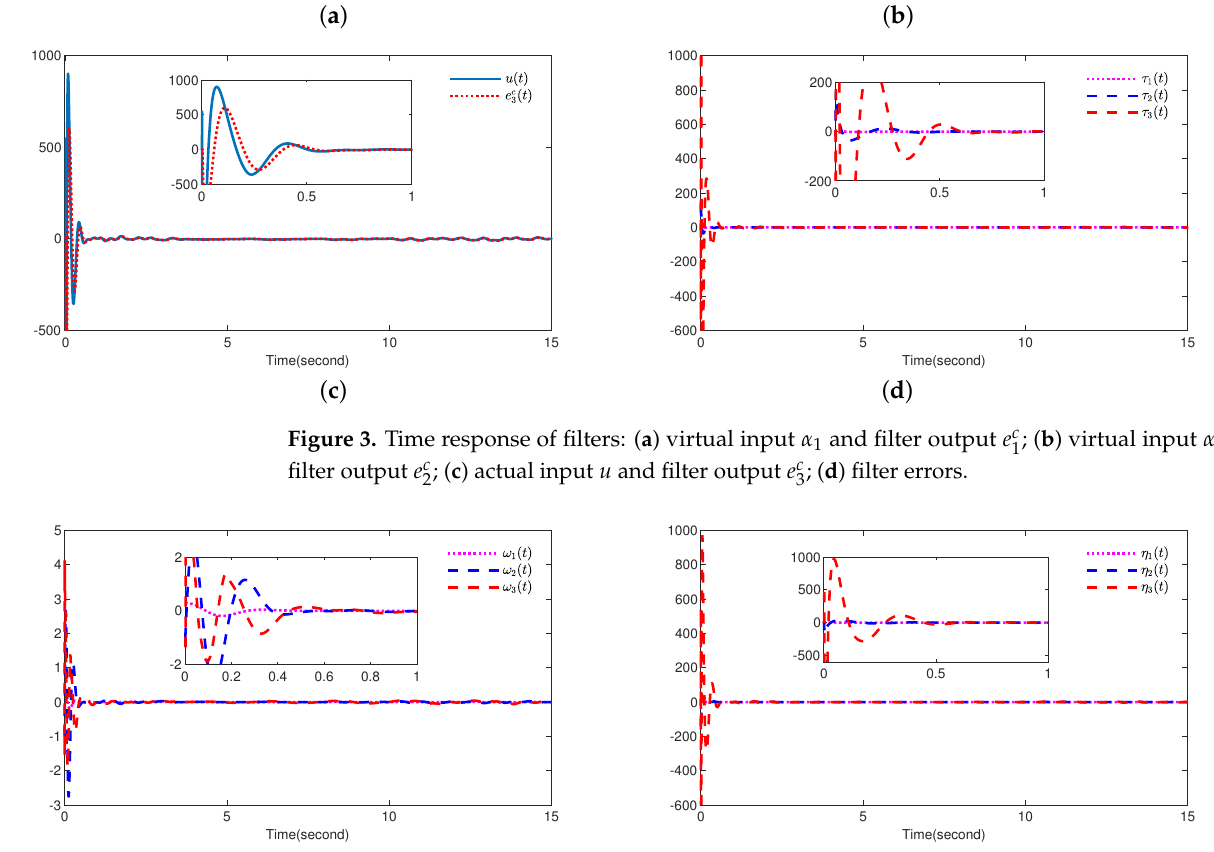
Figure 4. Auxiliary variables: ( a ) tracking errors by using the compound AFBC; ( b ) tracking error compensation